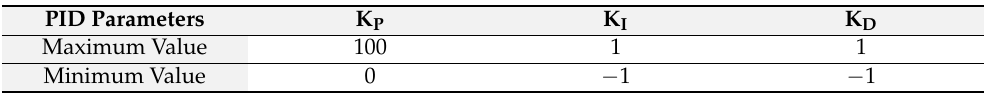
Table 2. The PID parameter